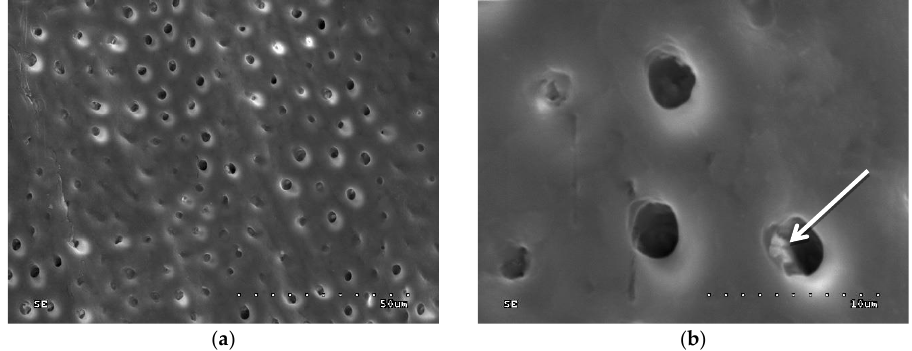
Figure 8. SEM image of dentine surface after application of 2.0% CHG for 15 s and acid etching—group 10: ( a ) 1000×; ( b ) 5000×. White arrow indicates peritubular dentine residue.